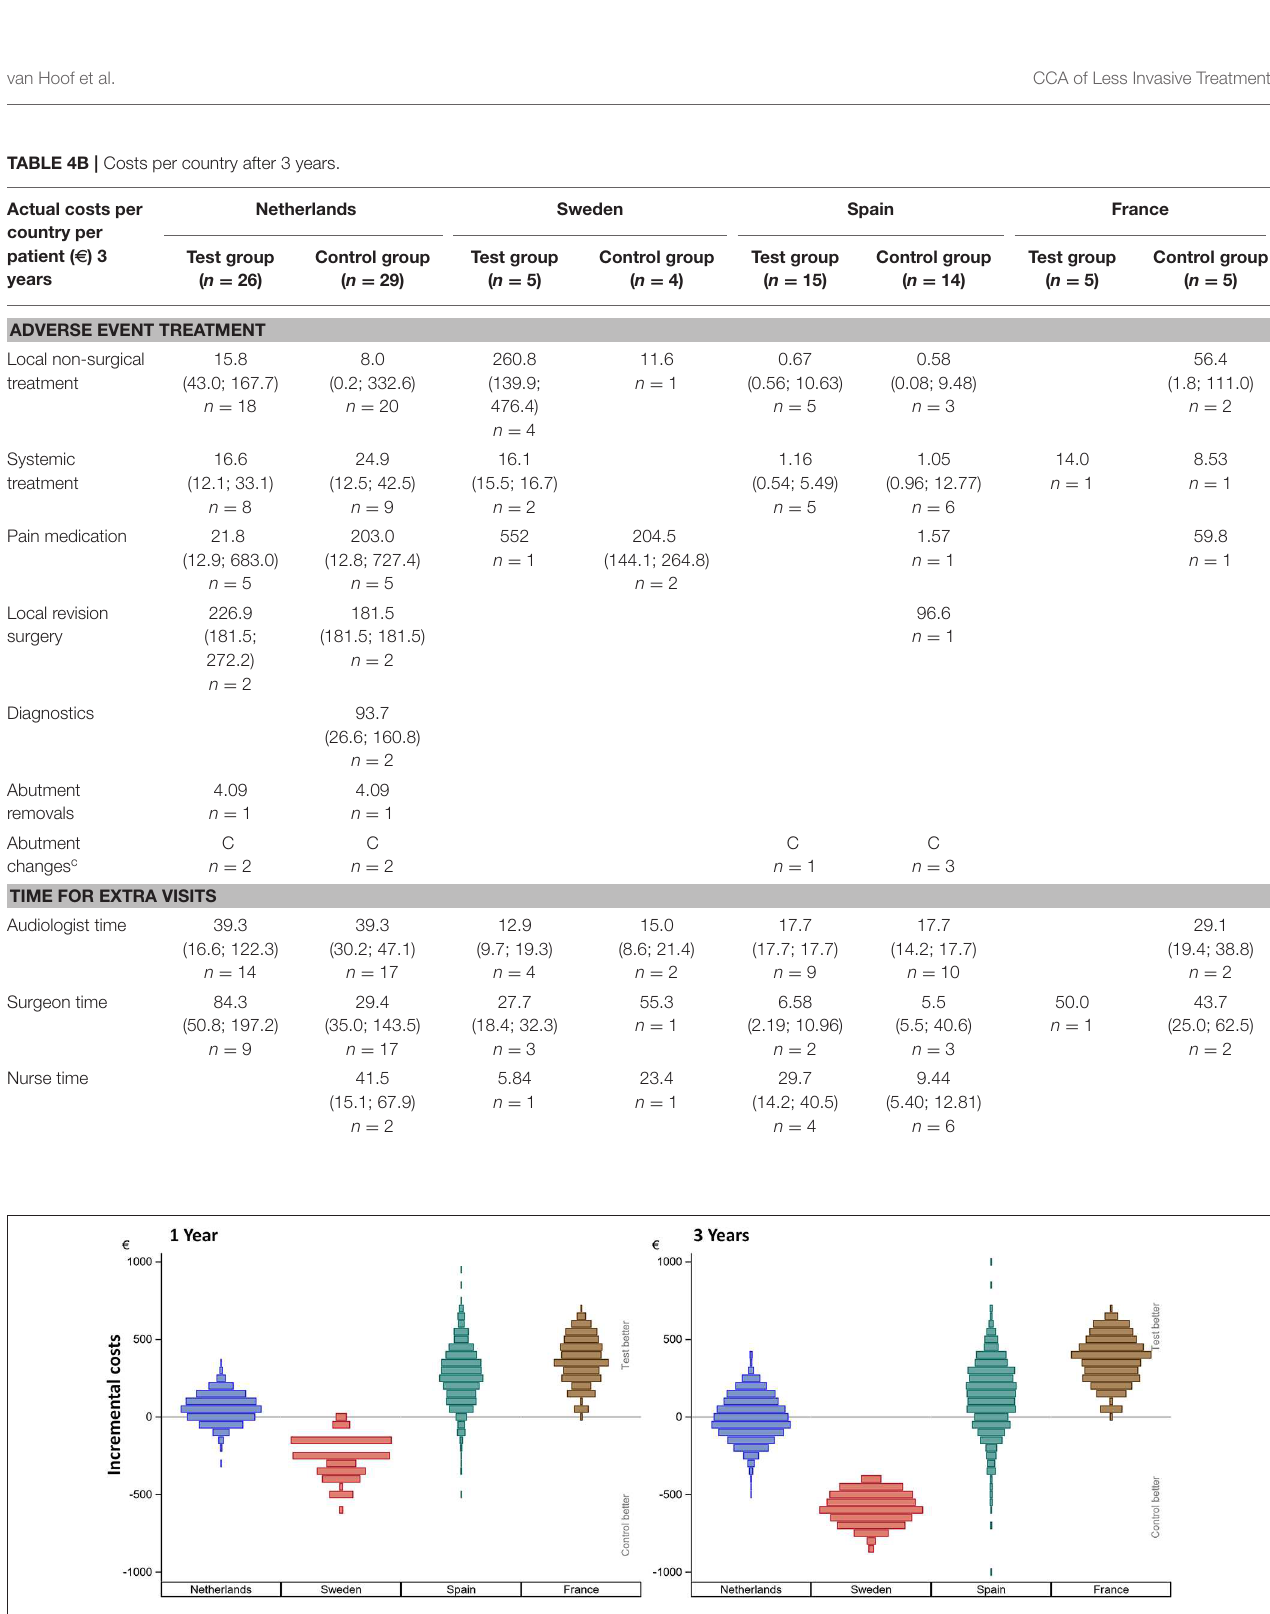
FIGURE 2 | Incurred incremental costs per country after 1 and 3 years. The incremental mean cost per subject, per country as simulated using 1,000 bootstraps using unrestricted random sampling which was displayed using a density histogram. A positive number indicates a cost saving in favor for the test intervention. For this simulation all subjects remained in their country of origin